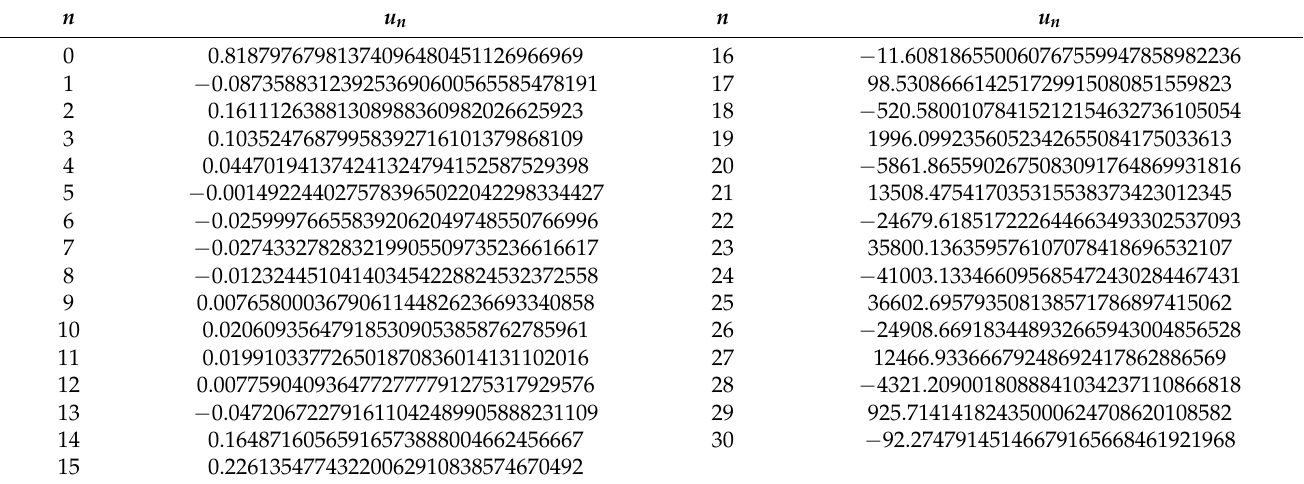
Table A3. The first 31 coefficients un in Equation (15) with 32 significant